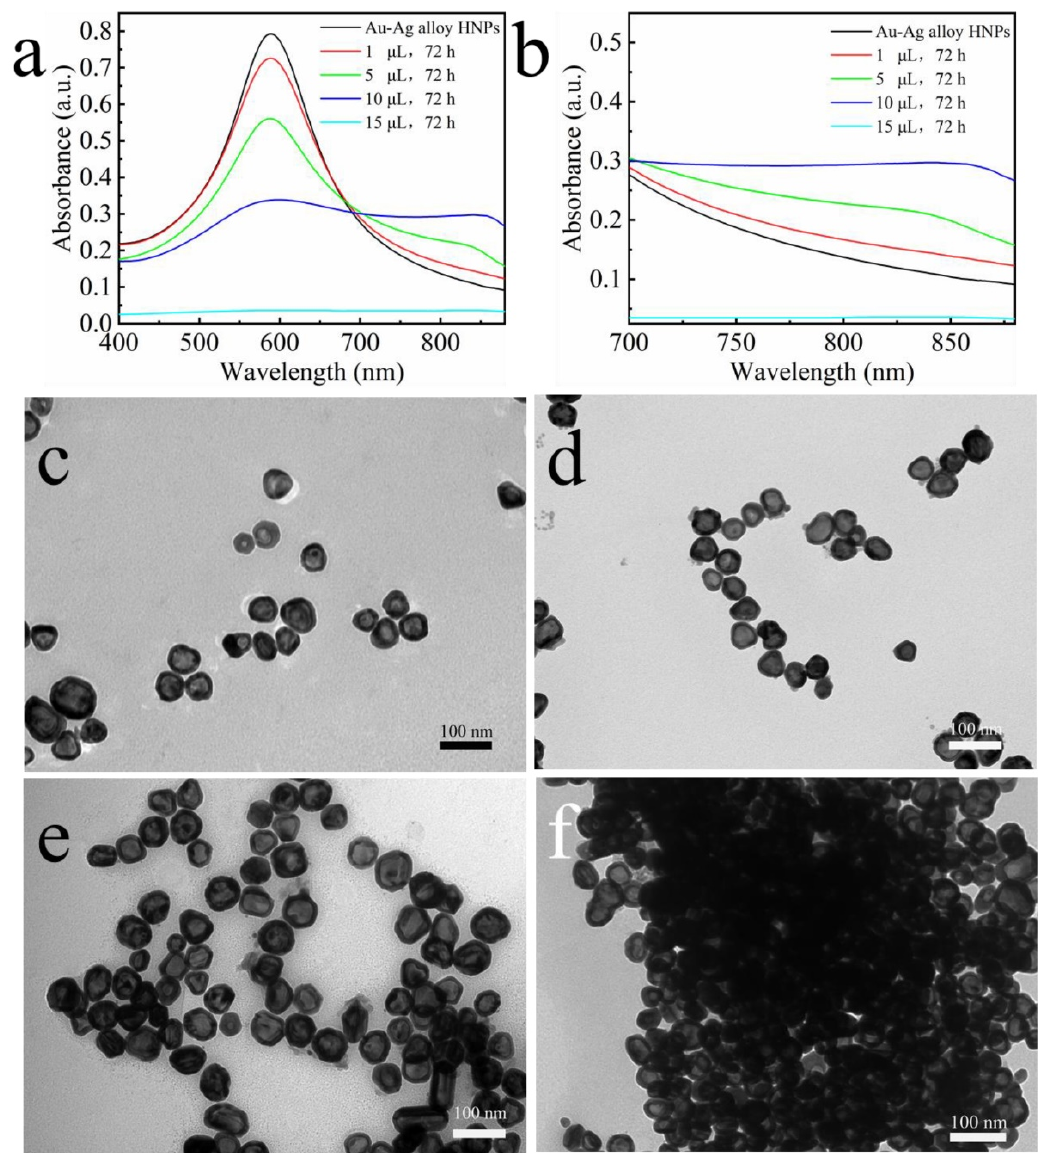
Figure 2. ( a , b ) UV–Vis spectral recordings of citrate-stabilized Au–Ag HNP s after 72 h of MEA addition. ( c – f ) Corresponding TEM images at different MEA additions ( c ) 1 μ L ( d ) 5 μ L ( e ) 10 μ L ( f ) 15 μ L.